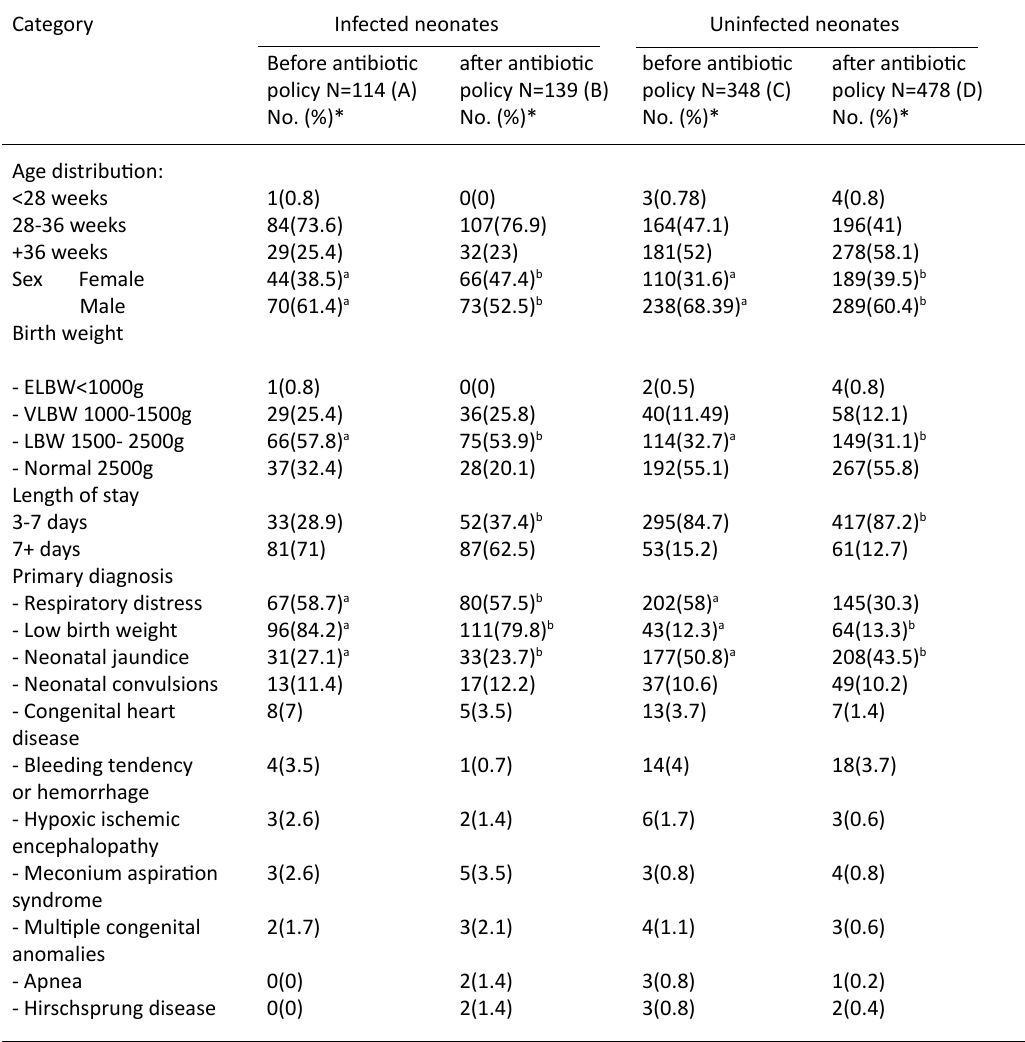
Table1. The characteristics of neonates admitted to NICU before and after the initiation of culture based antibiotic